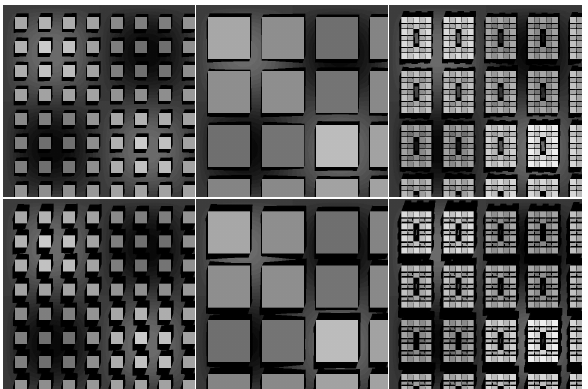
Figure 4: Synthetical DSMs with occlusions, top: occlusions at elevation 60 ◦ , bottom: occlusions at elevation 45 ◦